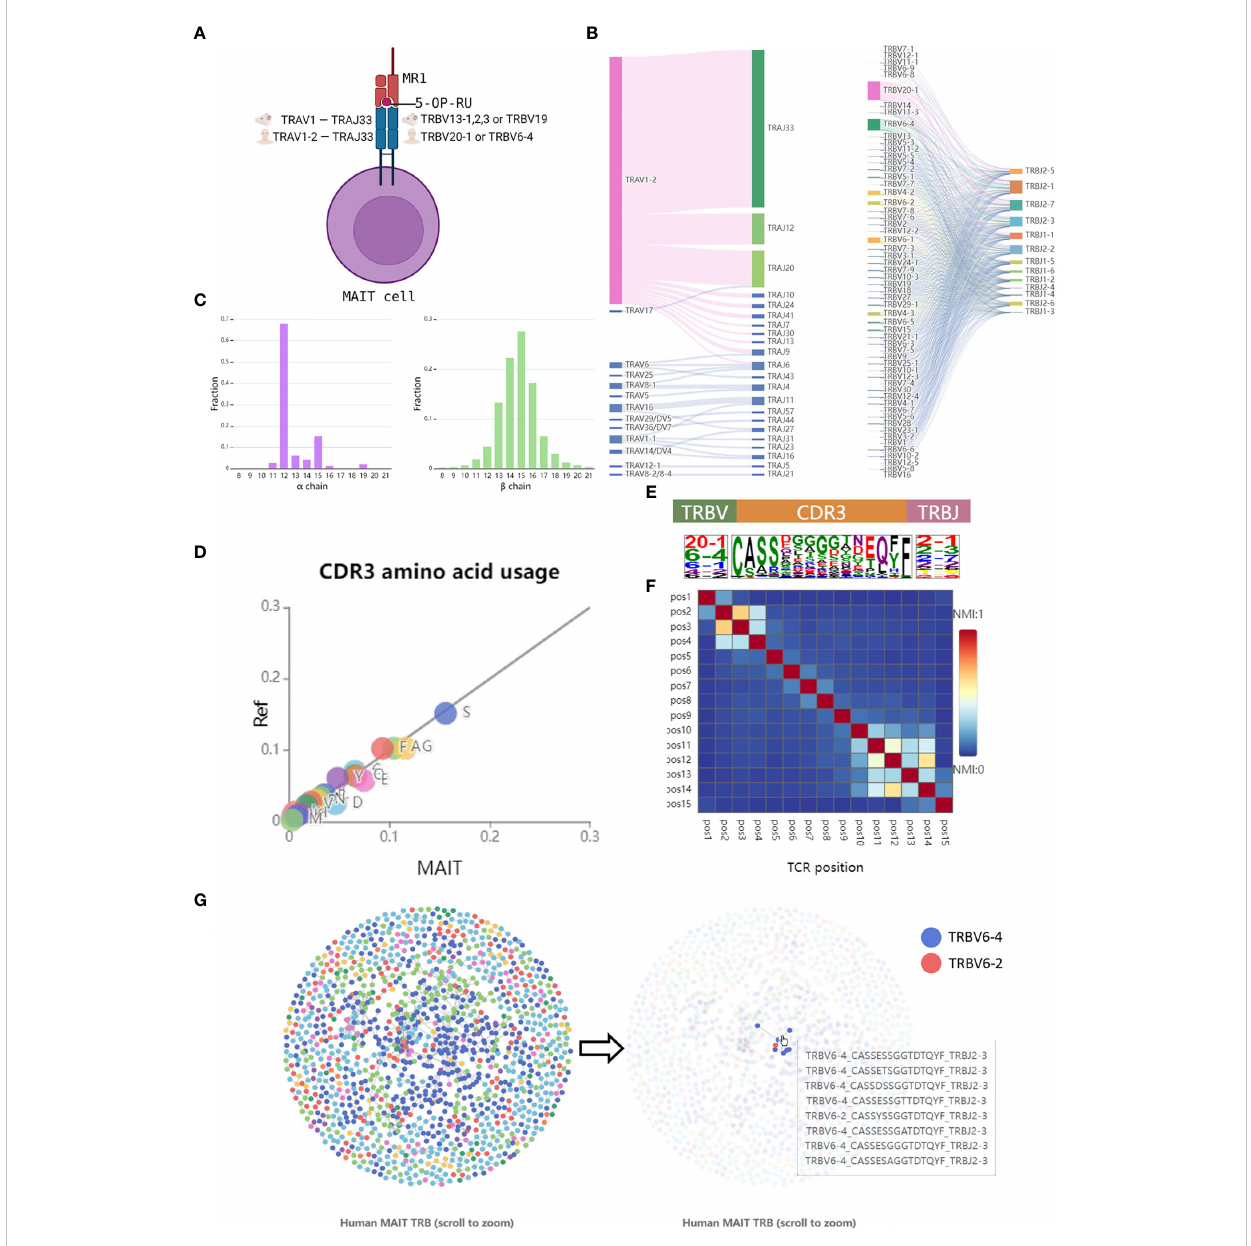
FIGURE 2 Browse the features of MAIT TCRs. (A) A schematic representation of MAIT cell. (B) V and J gene segment usage and gene-gene pairing landscapes are shown using vertical stacks (one for each V and J segment) connected by curved paths whose thickness is proportional to the number of TCR clones with the respective gene pairing. (C) CDR3 amino acid length distribution per chain. (D) The CDR3 b sequence logos including amino acids as well as TRBV and TRBJ were depicted by calculating the occurrence weights of different amino acids at the same position. The amino acids were colored by their chemical properties. (E) Amino acid usage between MAIT and conventional TCR b CDR3 sequences. A total of 100,000 conventional TCR b sequences were randomly selected from the dataset (37). (F) Heatmap showing the normalized mutual information value (NMI) between each pair of CDR3 b residues. The NMI takes values in the range of 0-1, with a larger NMI indicating a higher amino acid correlation. (G) The network graph is obtained by calculating the Hamming Distances between different CDR3 sequences. Nodes, which represent TCR clones, were colored by different TRBV genes. Edge was drawn if the distance between two clones is less than